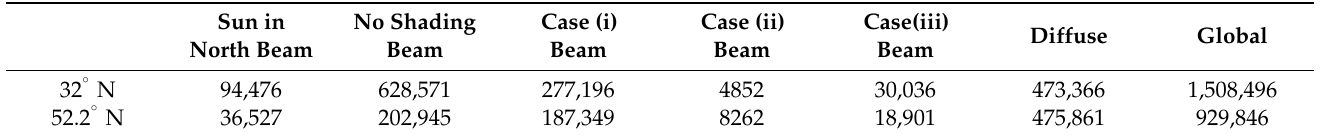
Table 1. North-facing surface: yearly incident irradiation, kWh.